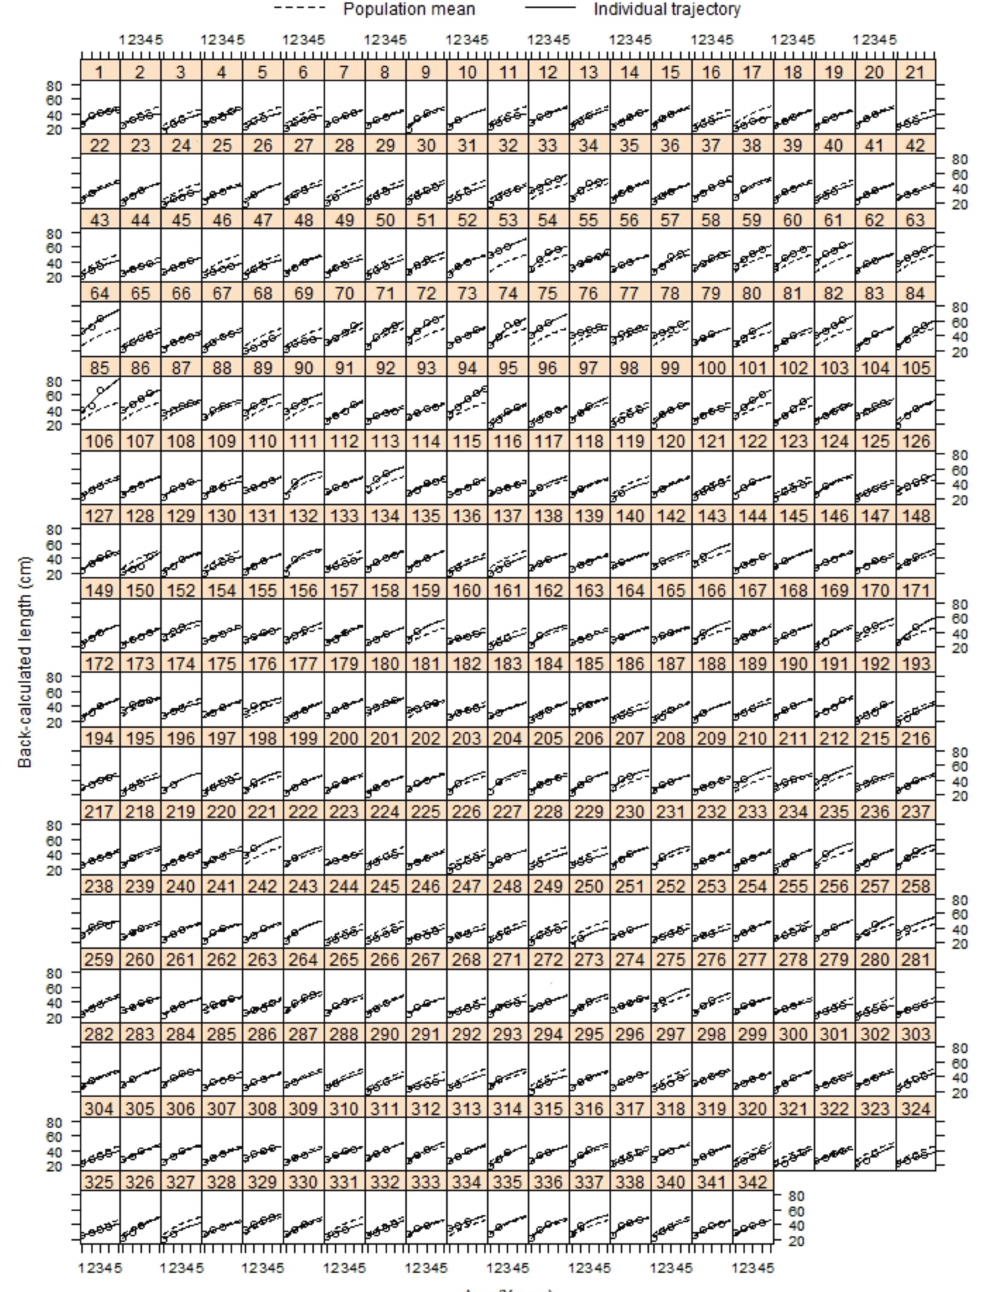
Fig. 6. Individual growth trajectories for Piaractus mesopotamicus collected in the Cuiabá River